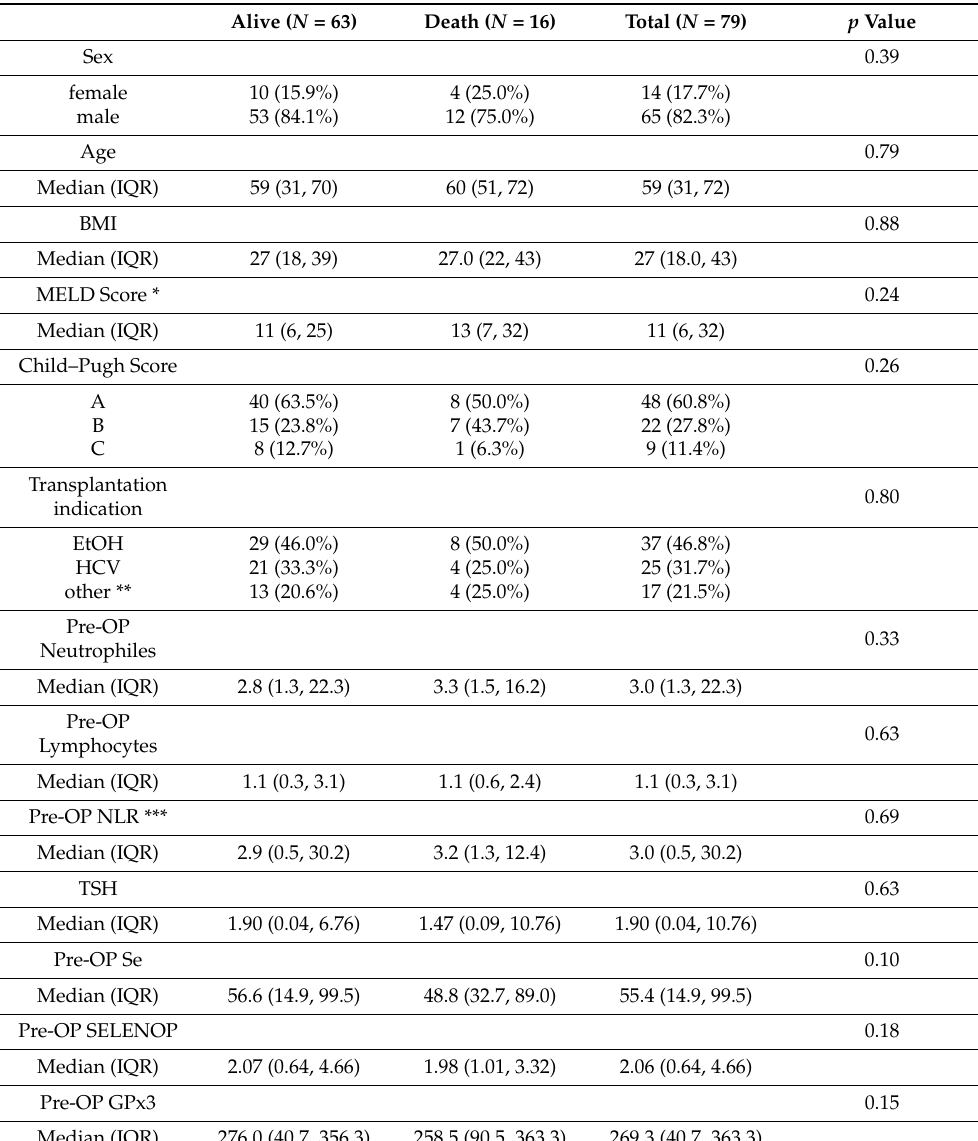
Table 1. Anthropometric and clinical characteristics of patients with hepatocellular carcinoma (HCC) at the time of